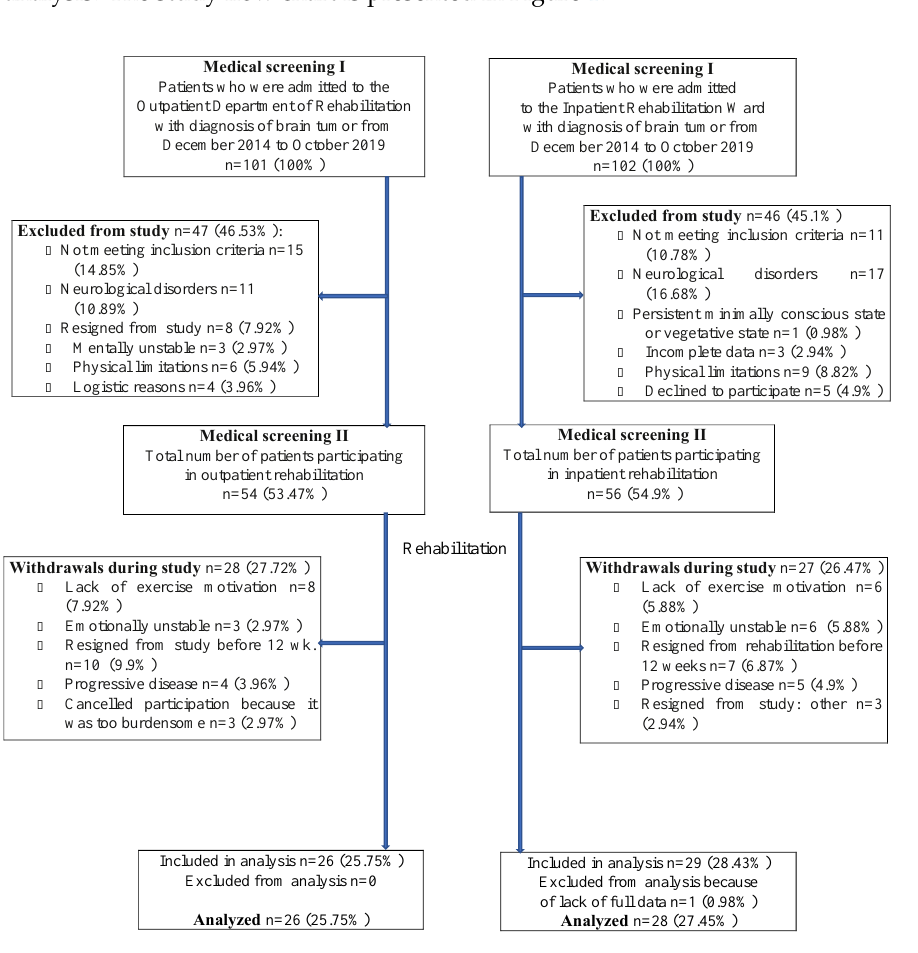
Figure 1. Flow of participants (as outpatients and inpatients) throughout the study.